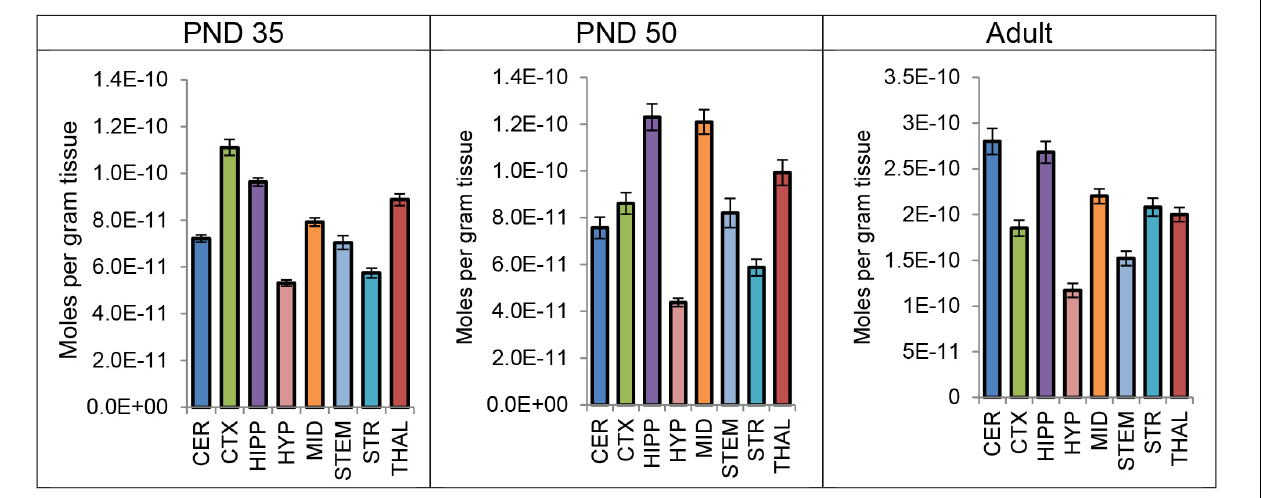
FIGURE 5 | Average level of CP 55,940 in each of eight brain regions in post-natal day (PND) 35 adolescent, PND 50 adolescent, and adult female CD1 mice 2 h after a single systemic 3 mg/kg CP 55,940 injection. Lipid levels are in moles per gram of tissue and error bars represent the standard error of the mean. CER, cerebellum; CTX, cortex; HIPP, hippocampus; HYP, hypothalamus; MID, midbrain; STEM, brainstem; STR, striatum; THAL,